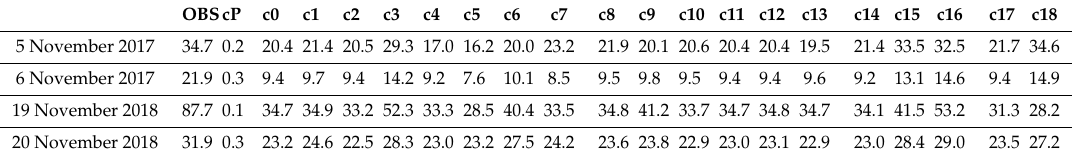
Table 11. Daily precipitation values (mm) averaged over the network of SCIA stations, for observational and model data (all configurations). Maximum deviation (cP) from the reference simulation with the initial condition ensemble.